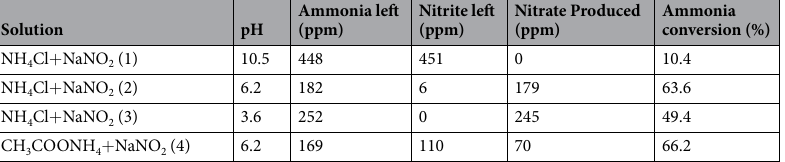
Table 3. Effect of pH and anions on the reaction between equimolar amounts of ammonia and nitrite. Conditions: